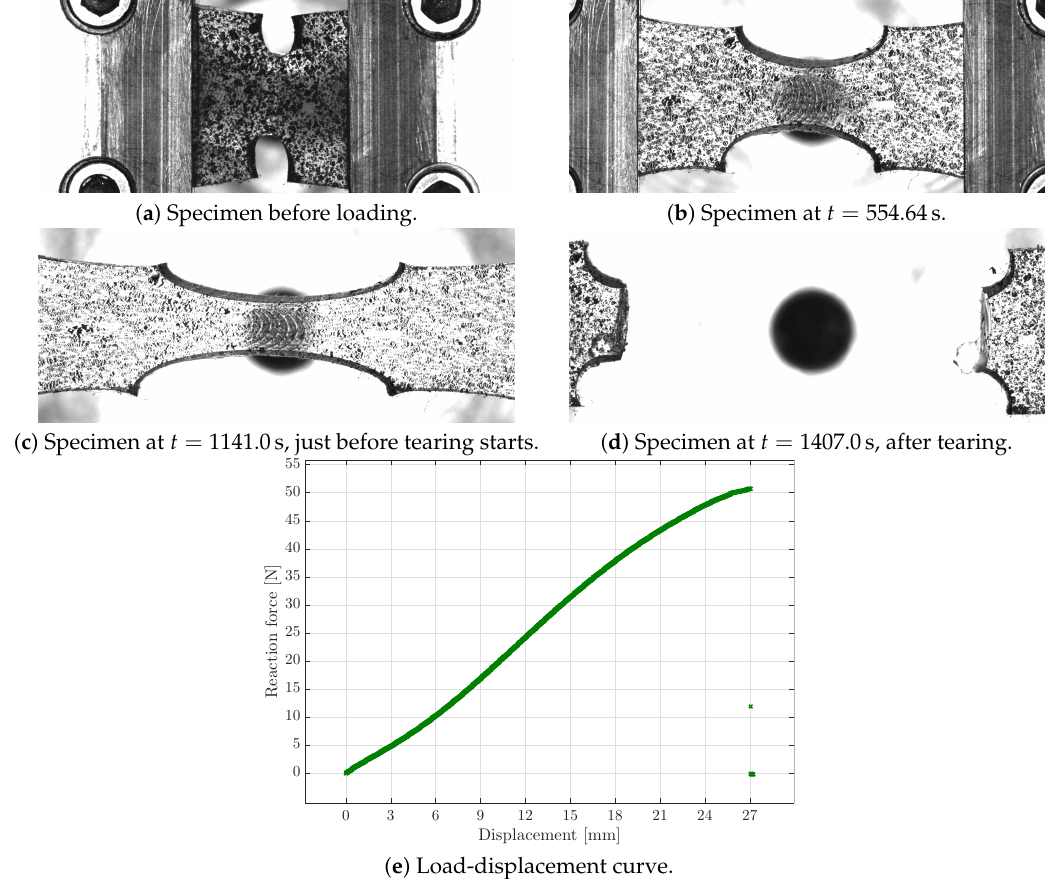
Figure 5. Experimental results of the tensile test of a notched specimen presenting photos of the sample at characteristic time steps, as well as the load-displacement